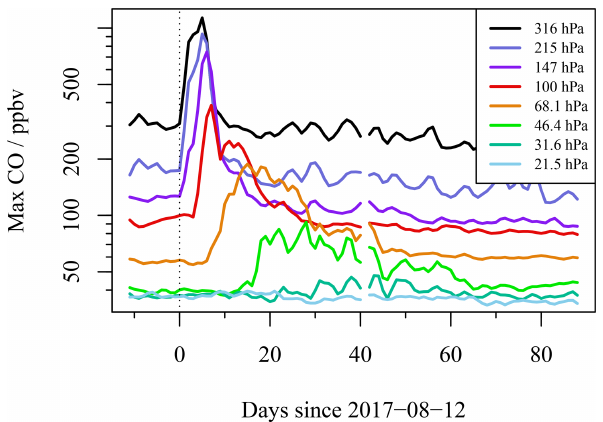
Figure 2. Time series of maximum CO values observed polewards of 27.5 ◦ N. The values shown are averages of the 10 highest ob- served values on each day between 27.5 and 83 ◦ N. A 3d smoothing has been applied to each